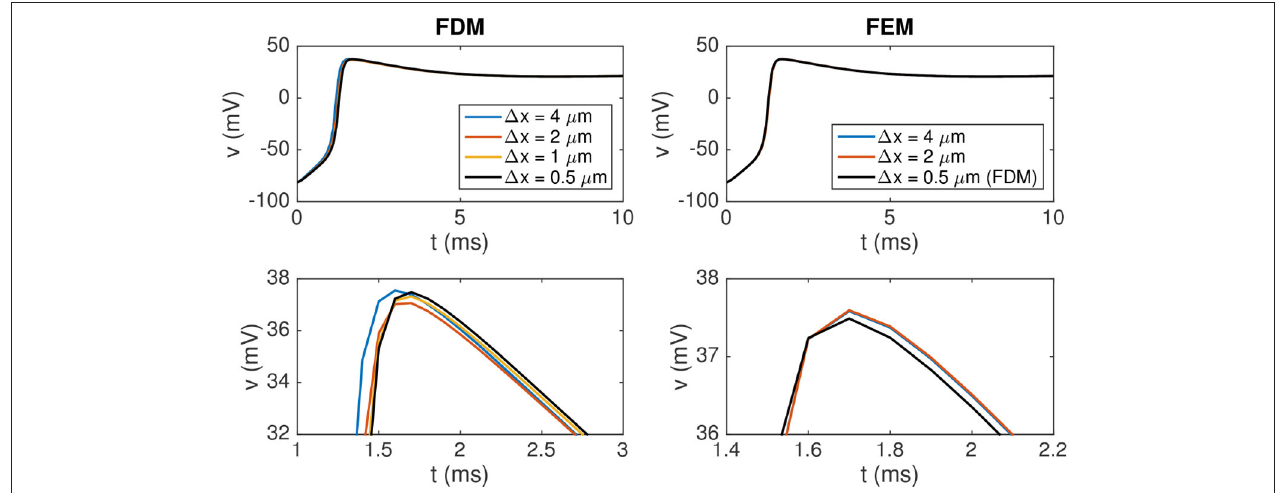
FIGURE 5 | Membrane potential at the point (112, 24, 16 µ m) for the finite difference and the finite element methods for two connected cells for some different values of 1 x = 1 y = 1 z . The upper panel shows the solution from t = 0 ms to t = 10 ms. In the lower panel , we zoom in on the peak to observe a difference between the solutions. Note that the scaling of the y axis is different for the two plots in the lower panel and that the FEM solutions for 1 x = 4 µ m and 1 x = 2 µ m are almost indistinguishable in the lower right plot. The parameter values used in the simulations are given in Tables 1 , 5 , and we apply a 1-ms-long stimulus current of 120 µ A/ µ F for the first 24 µ m of the first cell.